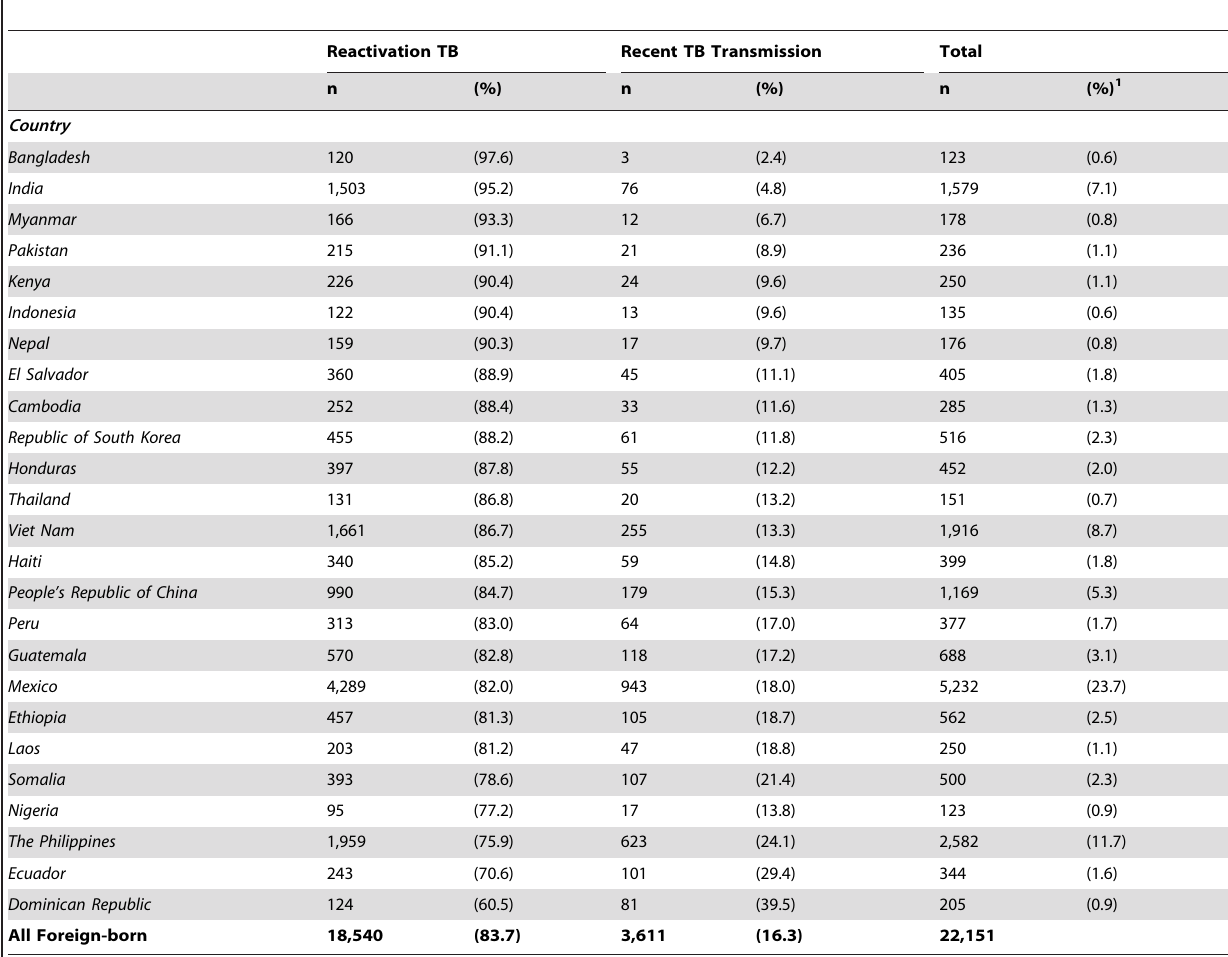
Table 1. Top twenty-five countries of origin with the highest proportion of reactivation TB among foreign-born persons diagnosed with TB in United States, 2005–2009*.